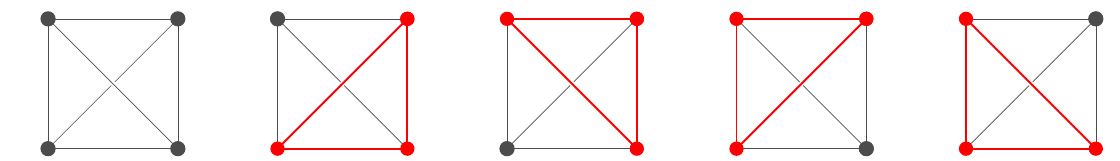
Figure 4. Left graph: the P 64 matrix with four pools (vertices) and six individuals (edges). The four graphs on the right represent the cases with three positive individuals (red edges) producing three positive pools (red